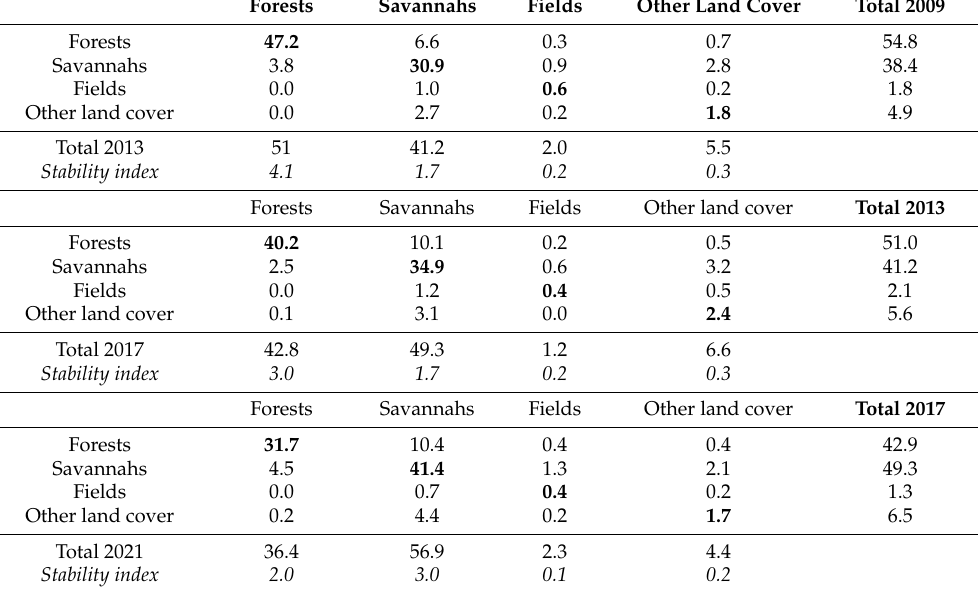
Table 1. Transition probability matrix of land cover between 2009–2013, 2013–2017 and 2017–2021. The initial and final dates are presented in the rows and the columns, respectively, with values in boldface referring to the stability proportions. The values in the table are expressed as a percentage (%) of the total area of the study area (986 km 2